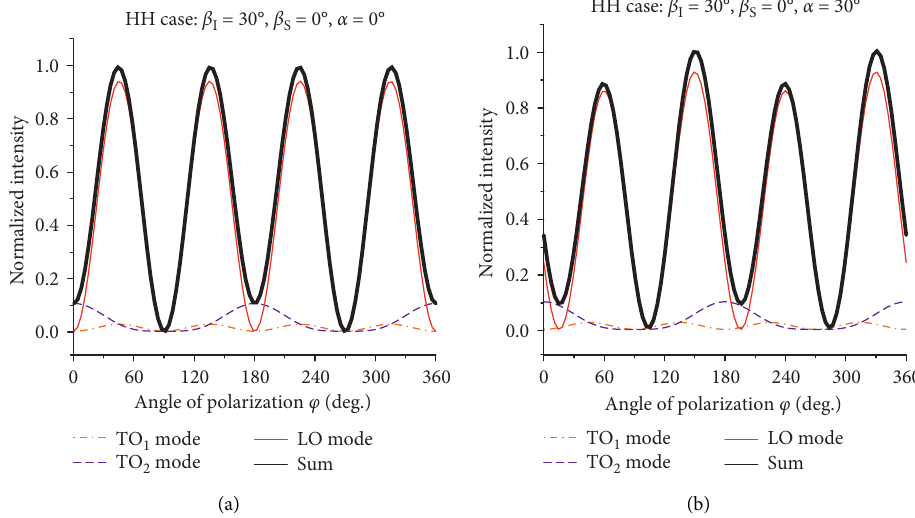
� 30 ° , β � 0 ° ) for different polarization I S